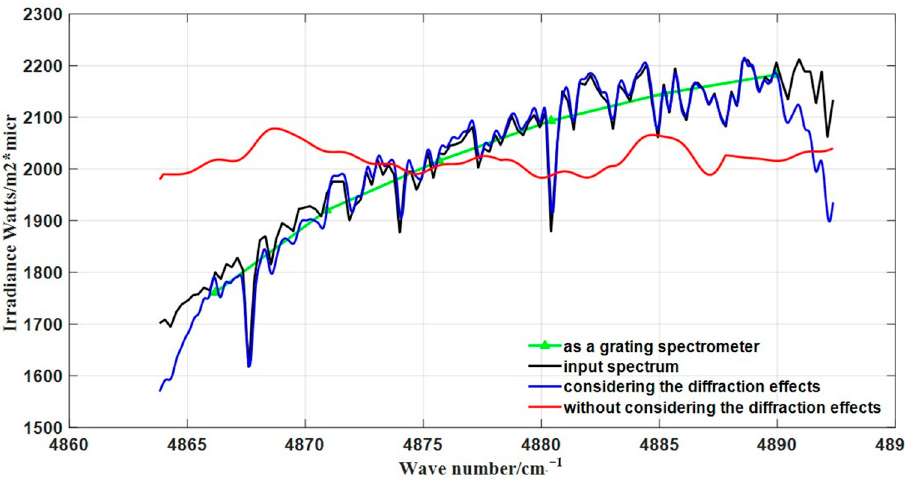
Figure 13. Comparison of recovered and input